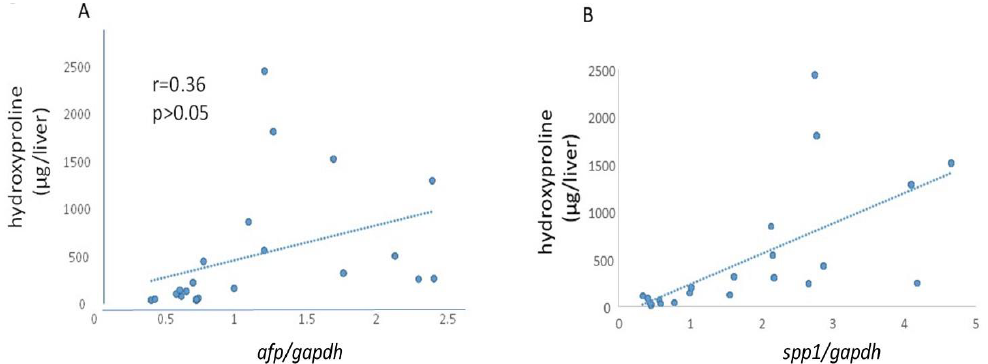
Figure 4. Oncogenes and liver scarring: ( A ) there is no relation between afp and hepatic hydroxyproline content in this model of NASH with fibrosis. ( B ) A direct and significant correlation exists between opn/spp1 and hepatic hydroxyproline content.